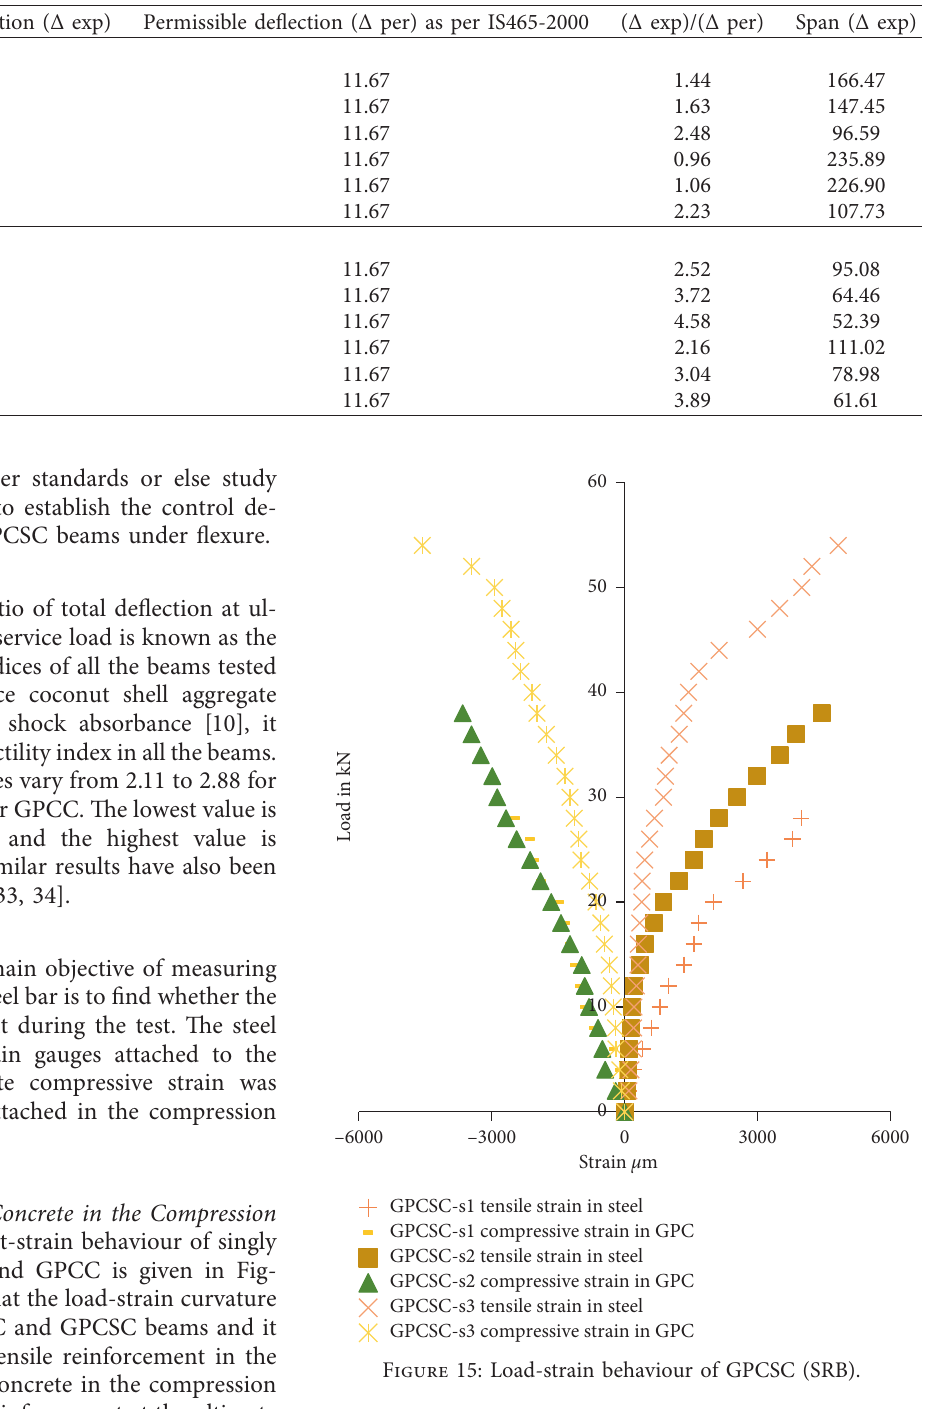
Table 9: Comparison of deflection with the Indian standard code.